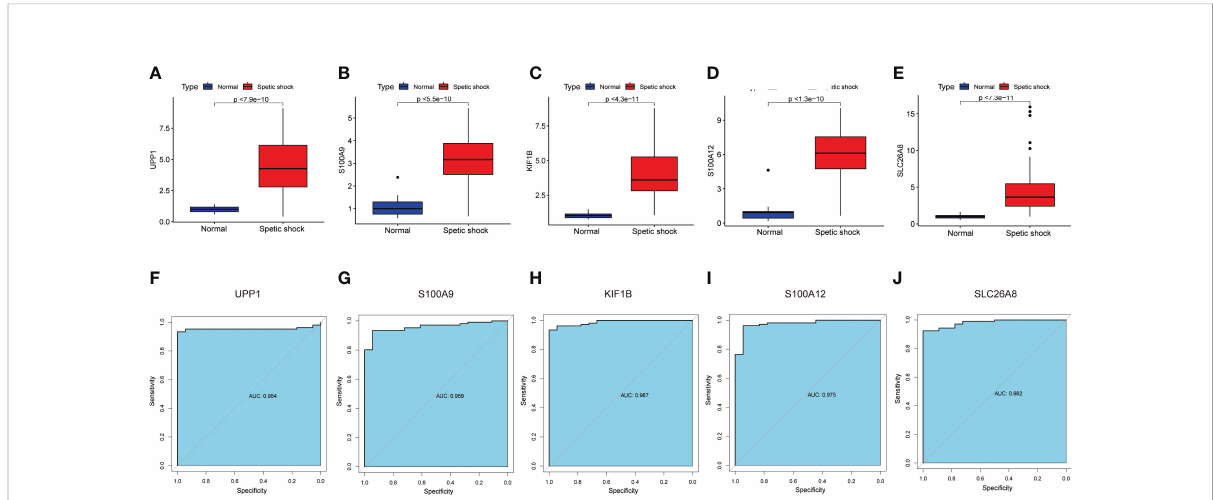
FIGURE 7 The performance of the signature genes in GSE13904. (A – E) The expression of signature genes between the pediatric septic shock and healthy cohort. (F – J) ROC showed the diagnostic performance of the signature